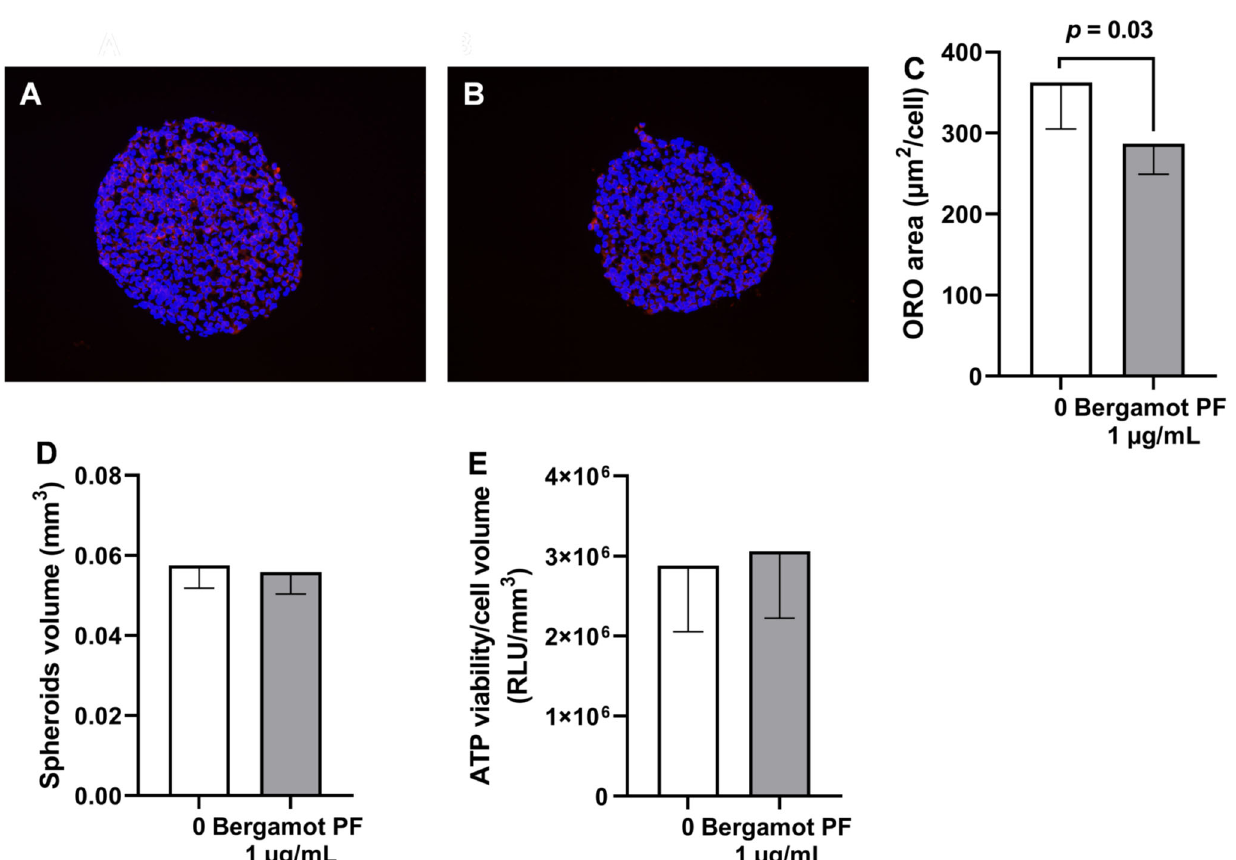
Figure 3. Treatment with 1 µ g/mL bergamot PF extract reduces intracellular lipid content in 3D spheroids. ( A ) HepG2 + LX2 cells were cultured as 3D spheroids for a total of 96 h. Initially, 24 h